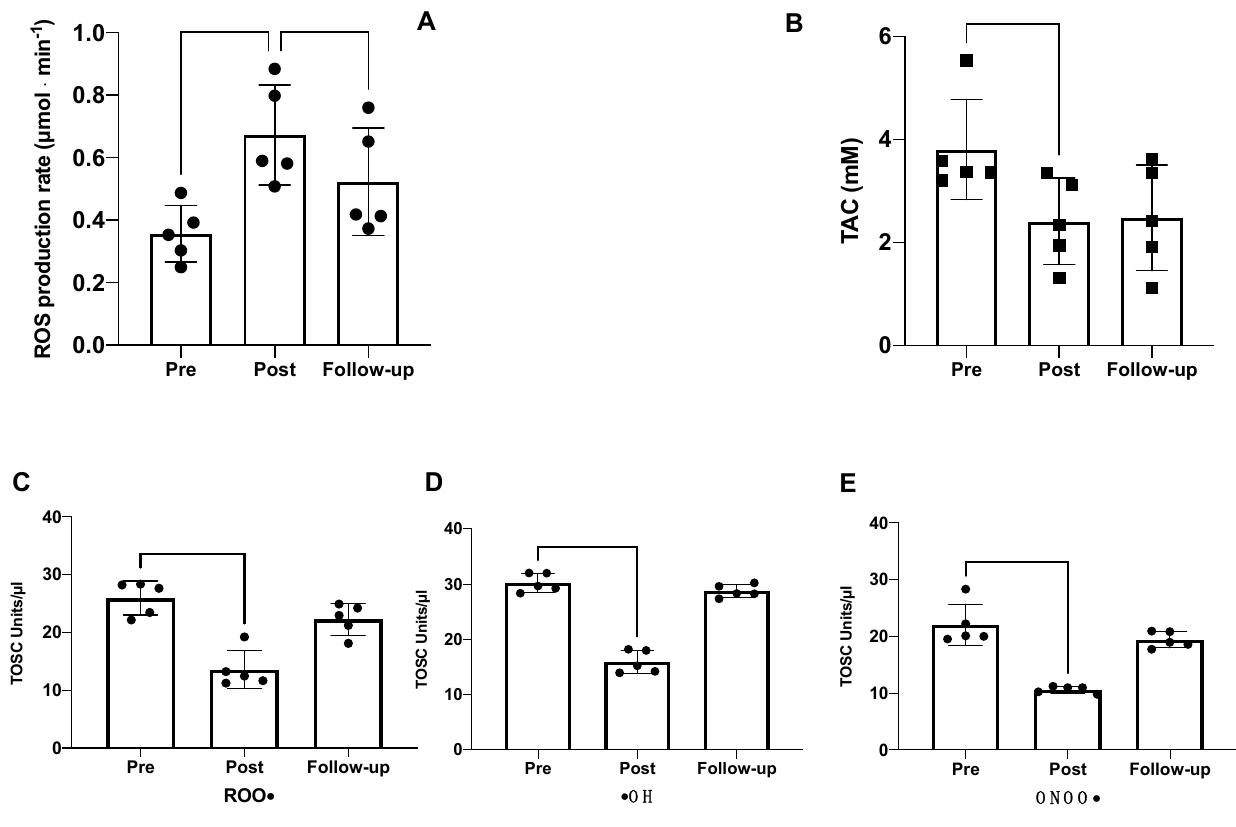
Figure 3. EPR results of ( A ) ROS production rate and ( B ) TAC via EPR detection. ORAC results of ( C ) anti-peroxyl (ROO • ), ( D ) anti-hydroxyl ( • HO), and ( E ) anti-peroxynitrite (ONOO • ) antioxidant activity of human seminal fluid. Significantly different data are displayed between brackets.